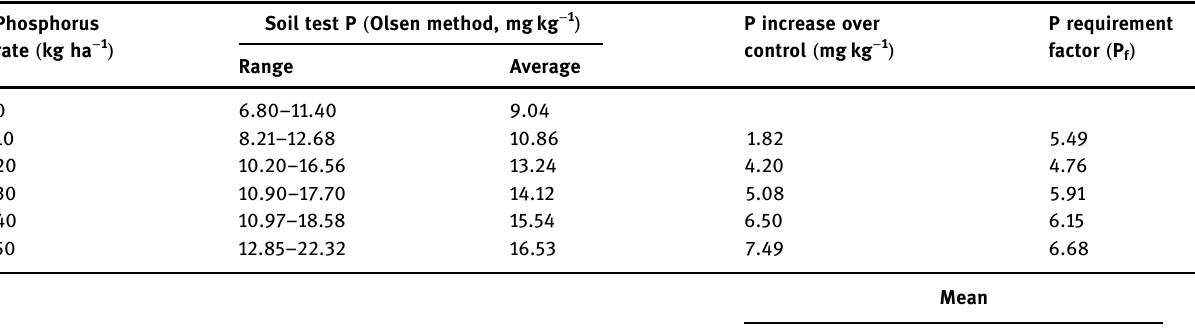
Table 3: Determination of phosphorus requirement factors ( P f ) for Olson method calculated, based on soil test P from di ff erent fertilizer rate treatments on malting barley on Nitisols of Lemu – Bilbilo district of Arsi zone